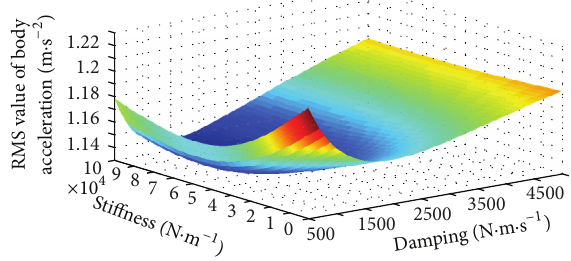
Figure 6: RMS map of body acceleration.